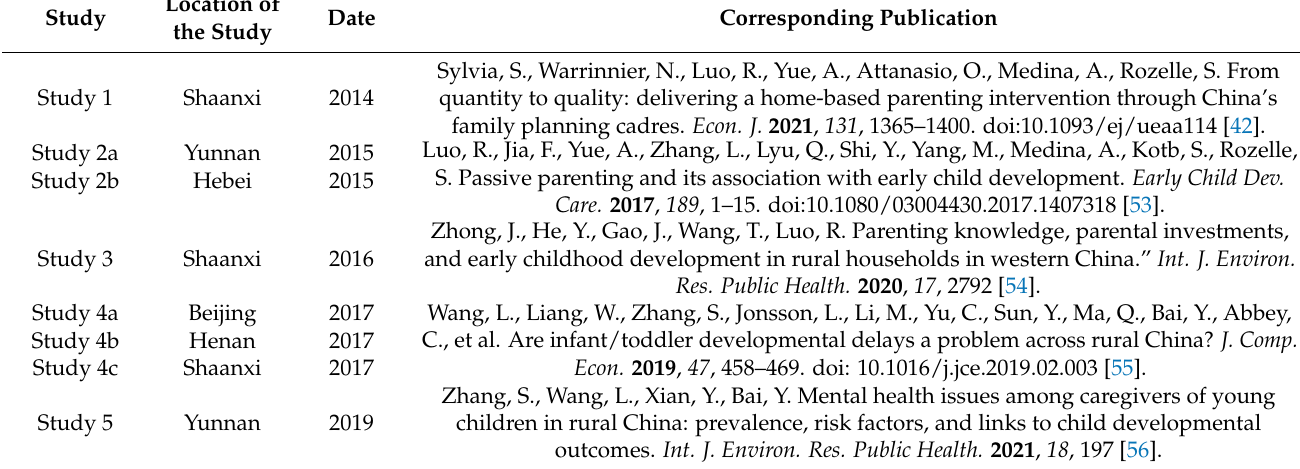
Table A1. Summary of studies included in the pooled dataset.